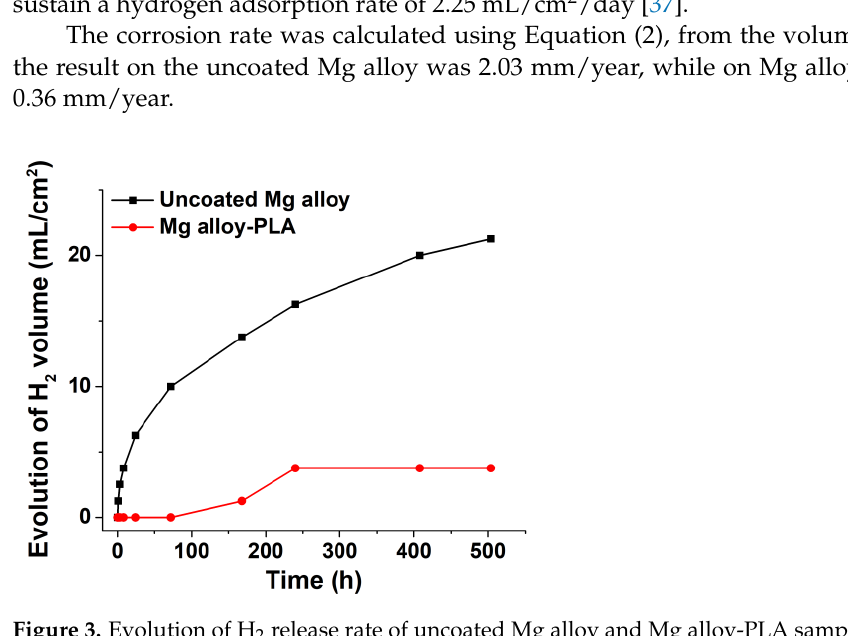
Figure 3. Evolution of H 2 release rate of uncoated Mg alloy and Mg alloy-PLA samples in SBF.